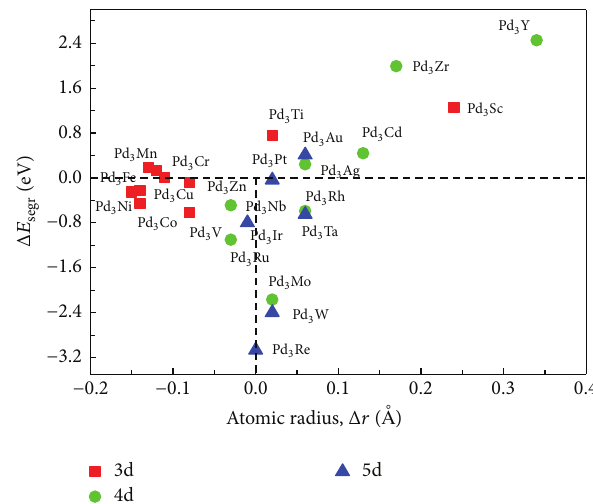
Figure 3: Plots of DFT-calculated segregation energy ( Δ𝐸 in Pd 3 M alloys as functions of atomic radii of alloying metals (M). Atomic radii are given with respect to that of Pd; that is, Δ𝑟 = 𝑟( M )− 𝑟( Pd ) .